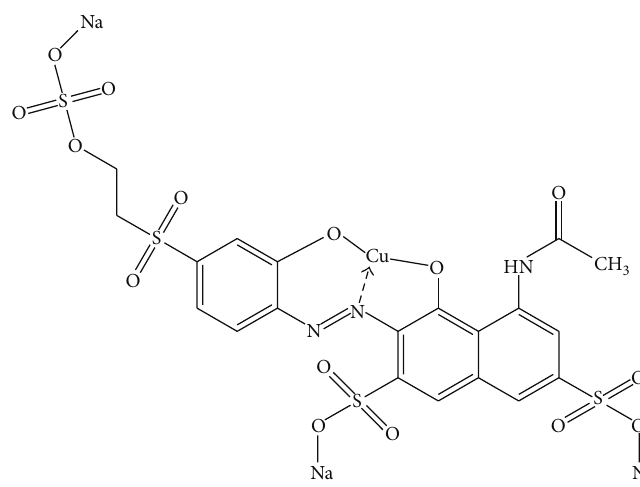
Figure 1: Structure of Reactive Violet